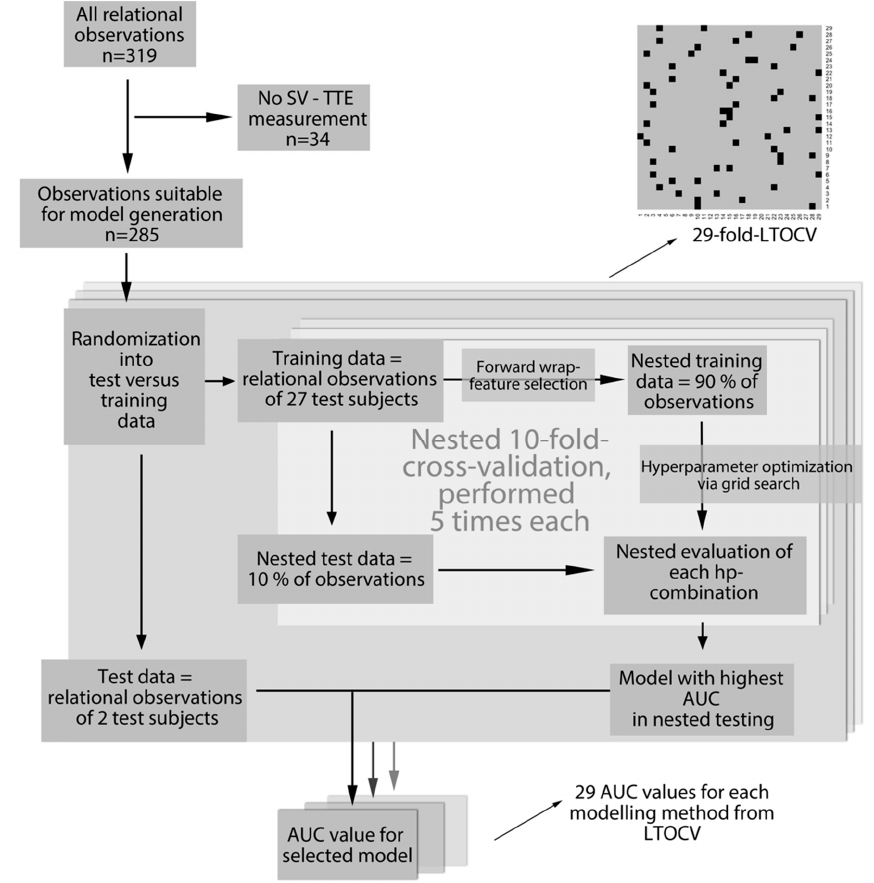
Figure 2. Machine-learning algorithm: schematic overview of the model generation process. At the top right, the grid shows the subject numbers on the x-axis, and the repetition of the “outer” test-subject-based LTOCV on the y-axis. Every repetition of cross-validation had two subjects’ data (marked with a black square) held back for testing of the model’s performance. The remaining data were used for model generation. AUC = area under the curve; hp = hyperparameter; LTOCV: leave-two-out cross-validation; SV-TTE: stroke volume measured by transthoracic echocardiography. Table 2. Overview of the feature selection and hyperparameter grid search of the machine- learning